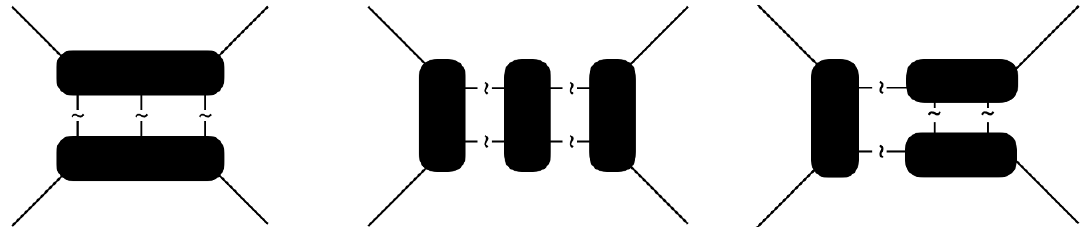
Figure 4 . All needed cut topologies, up to cyclicity.